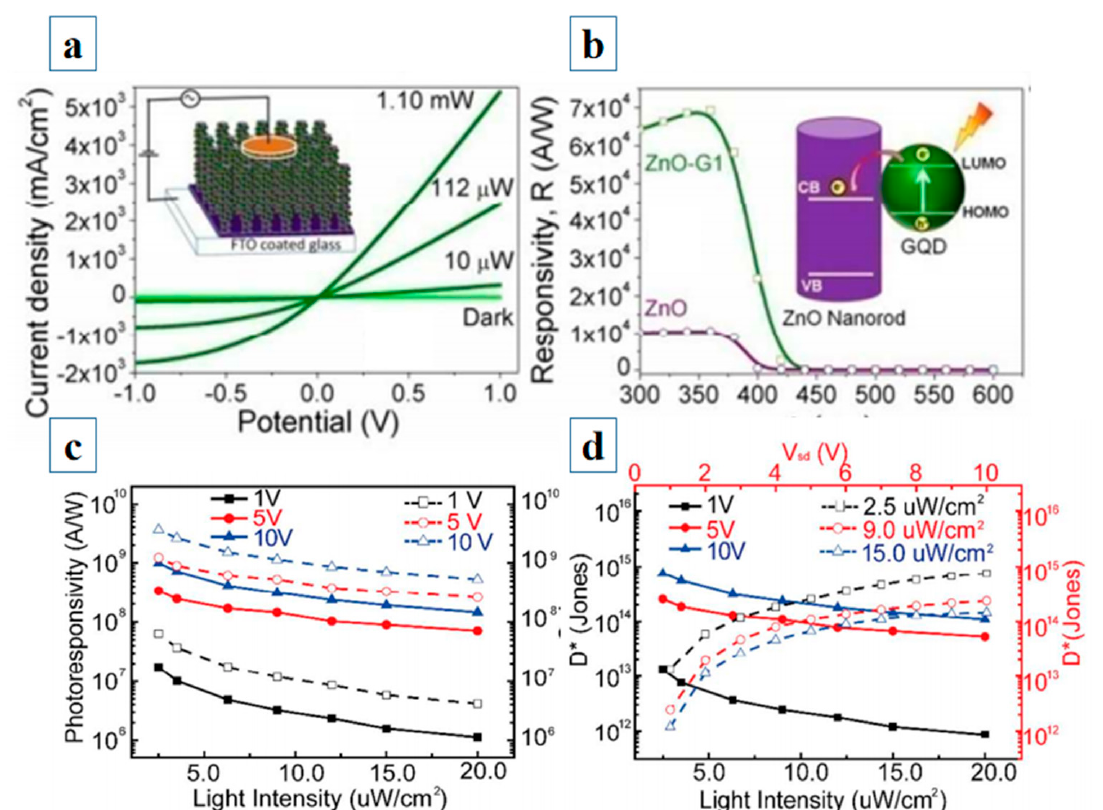
Figure 11. ( a ) ZnO–G1 under illumination by 365 nm UV light at different intensities. The inset shows a schematic of the device; ( b ) relationship between responsivity and wavelength for ZnO and ZnO–G1. The inset shows a schematic of electron transfer from a GQD to the ZnO nanorods; ( c ) photoresponsivity (solid with left-hand scale) and gain (dashed with right-hand scale) as functions of the UV light intensity at different V sd ; ( d ) detectivity D* as a function of the UV (340 nm) light intensity (black axis and solid curves) and V sd (red axis and dashed curves).